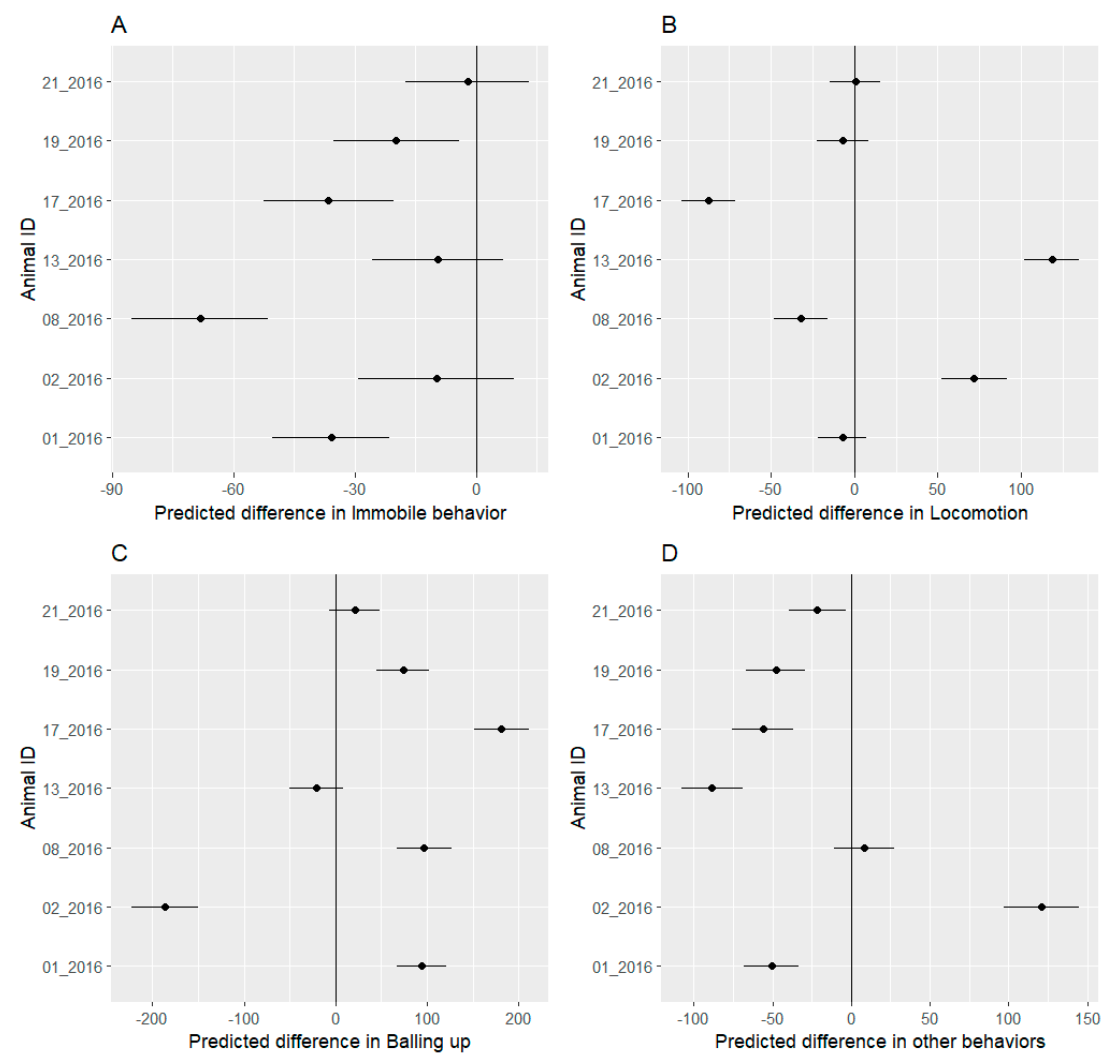
Figure 3. Mean predicted values with 95% confidence interval for di ff erences in daily behavior counts of immobile behavior ( A ), locomotion ( B ), balling up ( C ) and other behavior ( D ) of seven hedgehogs between the pre-festival and festival phases. The predicted di ff erence represents changes in behavior event counts. Negative values represent a decrease in the behavior counts during the festival while positive values represent an increase during the festival. We considered all di ff erences to be significant where the confidence interval does not include 0. Individual hedgehogs showed markedly di ff erent behavioral changes during the festival